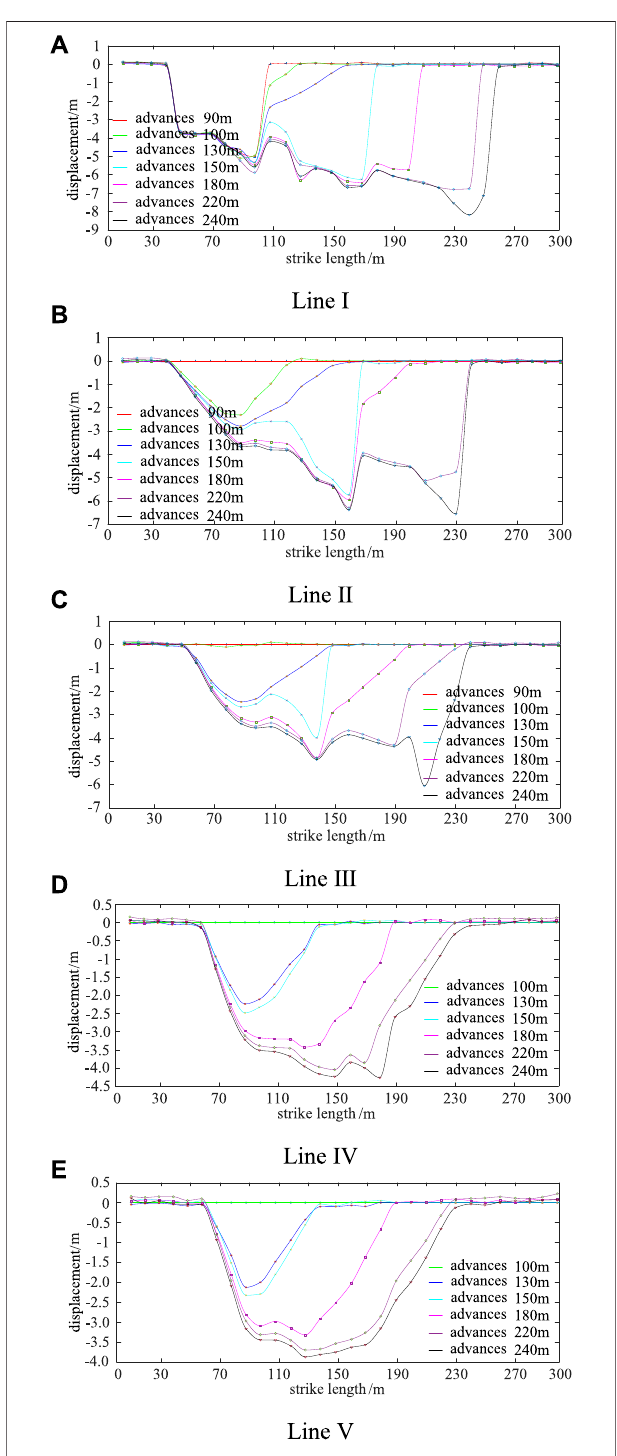
FIGURE 7 | Variations in the settlement curves of overlying strata in the recovery process. (A) Line Ⅰ ; (B) Line Ⅱ ; (C) Line Ⅲ ; (D) Line Ⅳ ; (E) Line V.